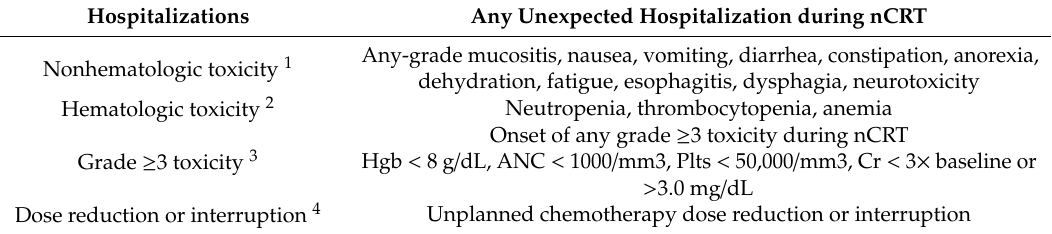
Table 1. Definitions of toxicity